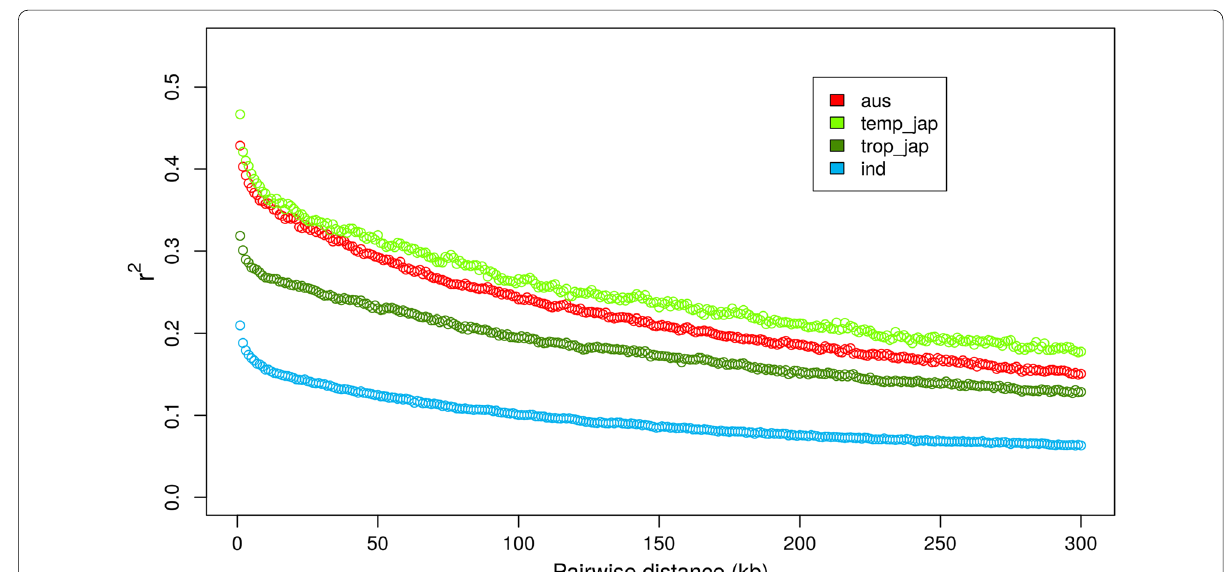
Fig. 4 Pair‑wise marker linkage disequilibrium (LD) estimation within each